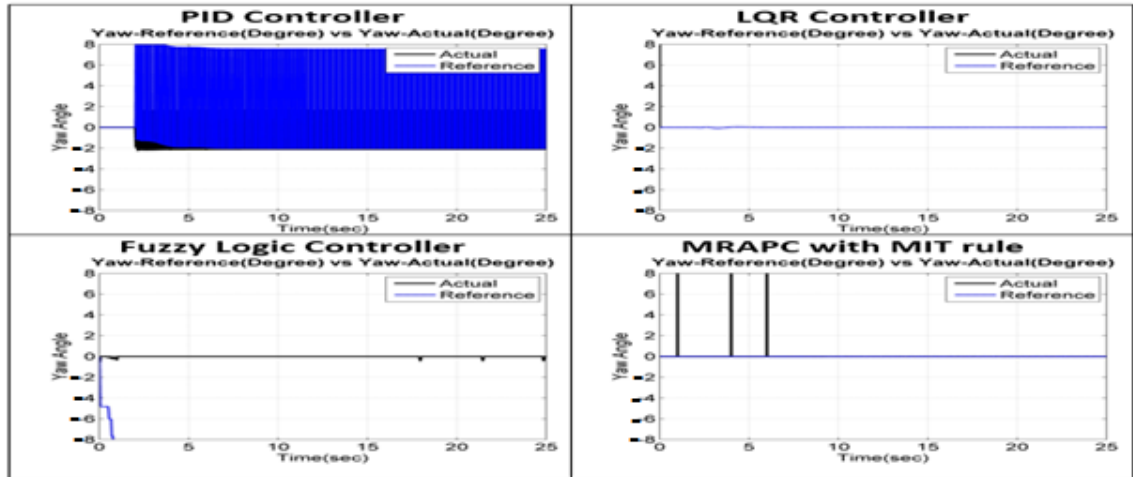
Figure 17. Pitch ( θ ) Control result depending on step input for all control systems. Figure 17. Pitch (θ) Control result depending on ste p input for all control systems